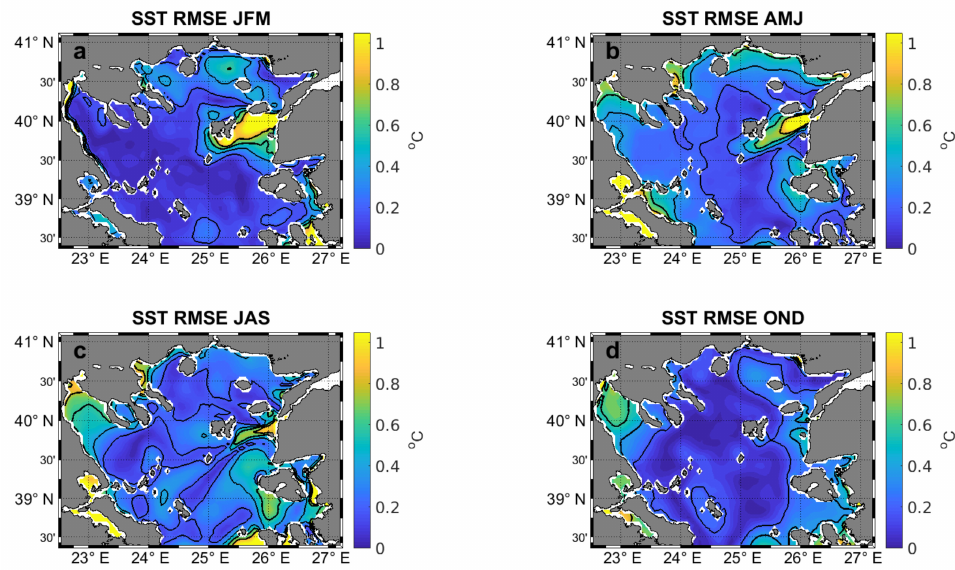
Figure 3. Seasonal Sea-Surface Temperature RMSE for the mean climatological year for the period from 1986 to 2013. ( a ) winter, ( b ) spring, ( c ) summer, and ( d ) autumn months.